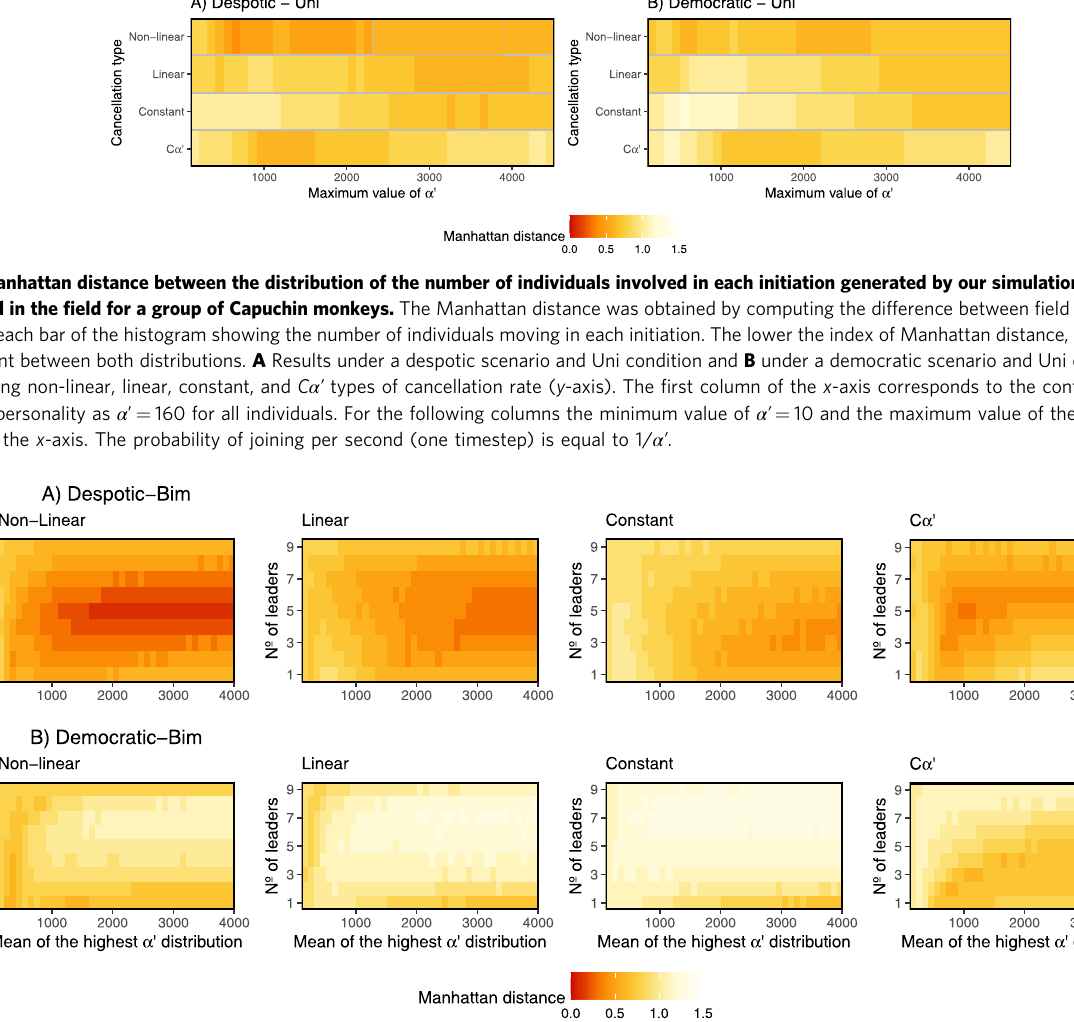
Fig. 6 Manhattan distance between the distribution of the number of individuals involved in each initiation generated by our simulations and the one observed in the fi eld for a group of Capuchin monkeys. The Manhattan distance was obtained by computing the difference between fi eld and simulation data for each bar of the histogram. The lower the index of Manhattan distance, the greater the agreement between both distributions. A Results under a despotic scenario and Bim condition and B under a democratic scenario and Bim condition, both considering non-linear, linear, constant and C α ’ types of cancellation rate. The y -axis indicates the number of leaders (number of individuals drawn from the lowest α ’ distribution) within a group. The fi rst column of the x -axis corresponds to the control simulation without personality as α ’ = 160 for all individuals. For the following columns the mean of the low α ’ distribution was fi xed at 160, while the mean of the highest α ’ distribution is given by x -axis. The probability of joining per second (one timestep) is equal to 1/ α ’